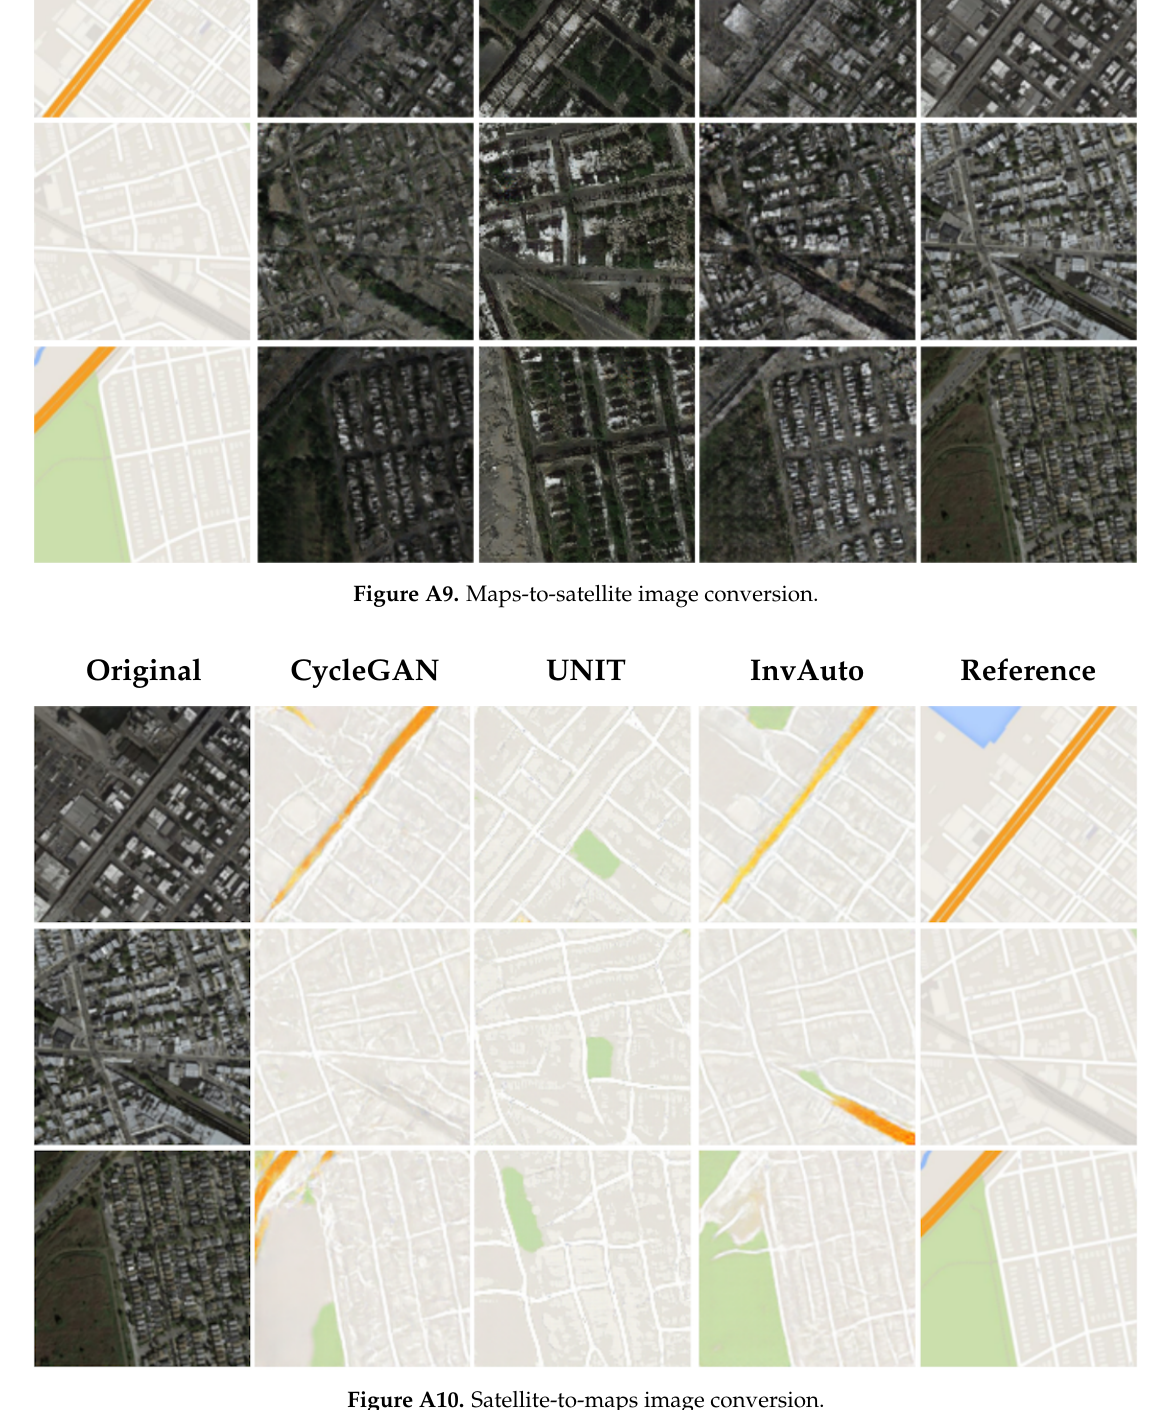
Figure A10. Satellite-to-maps image